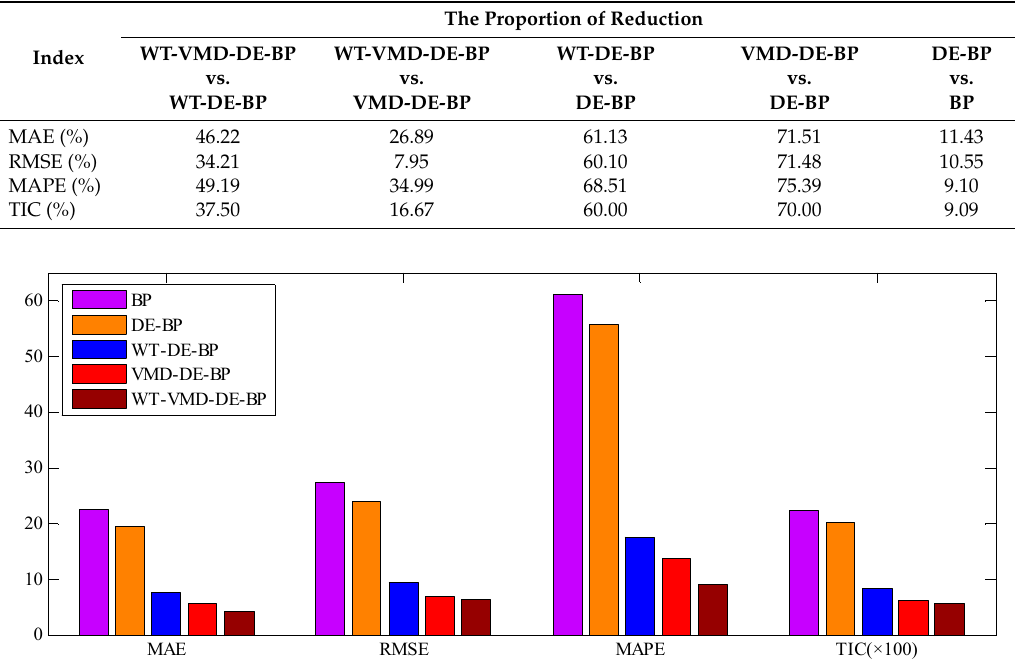
Figure 19. Error graphics of different models (Tianjin).